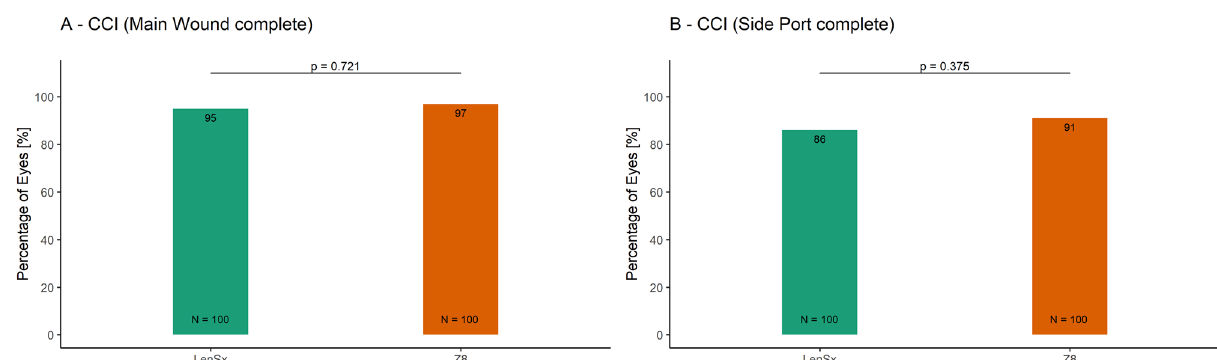
Figure 4. The proportion of eyes with complete CCI in the LenSx and the Z8 laser group ( A ) Main incision. ( B )